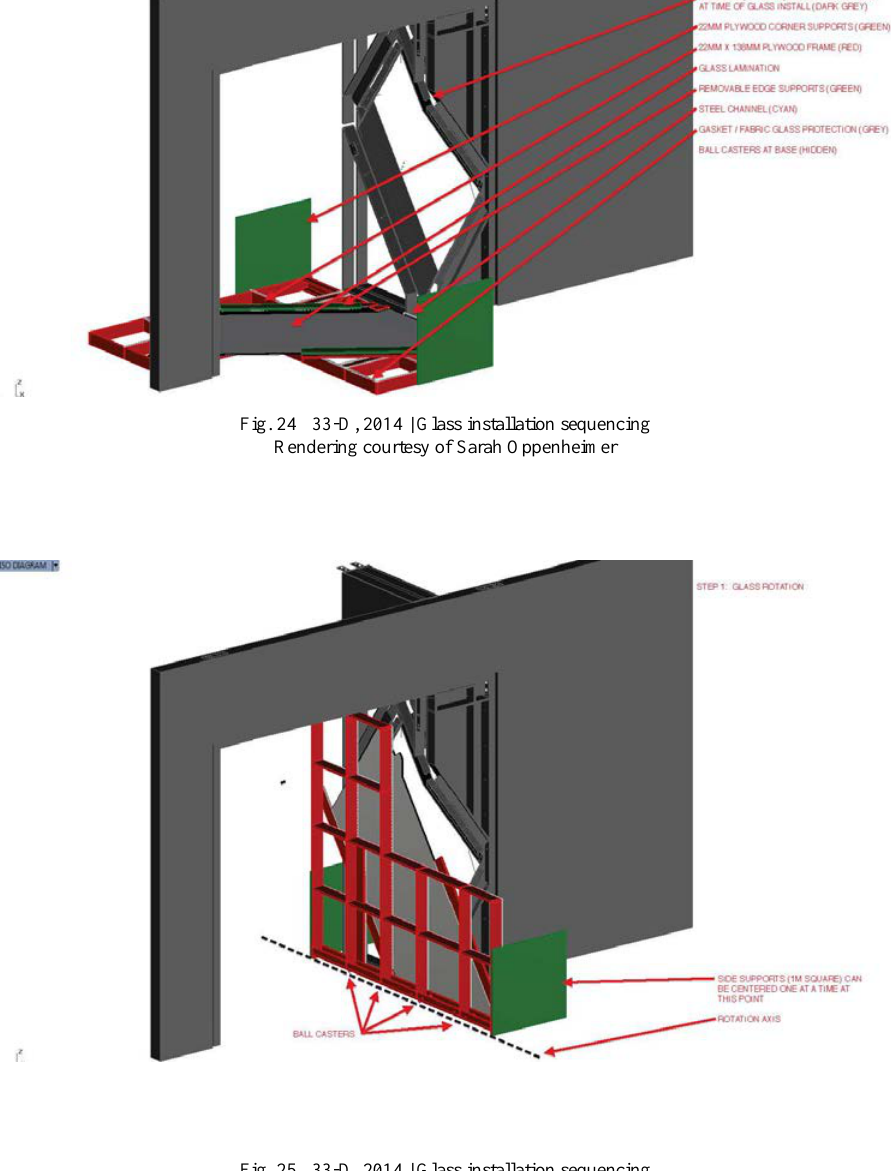
Fig. 25 33-D, 2014 | Glass installation sequencing Rendering courtesy of Sarah